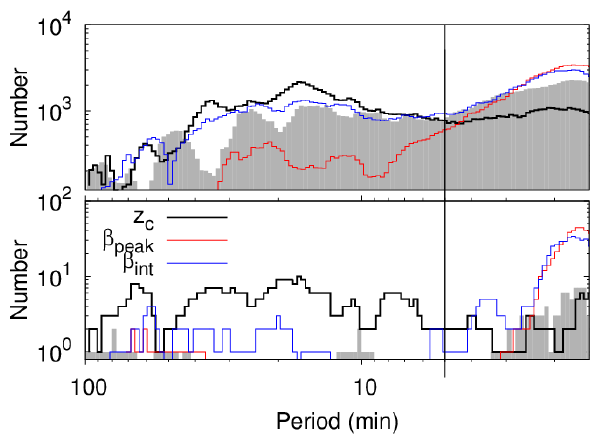
Fig. 8. Histogram of locally (top) and globally (bottom) significant periods obtained from wavelet spectra of z c (t) , β peak (t) and β int (t) . The periods from a time series of random numbers that accidentally appear significant are shown in shaded grey. The Brunt–Väisälä pe- riod of 5min is indicated by a vertical